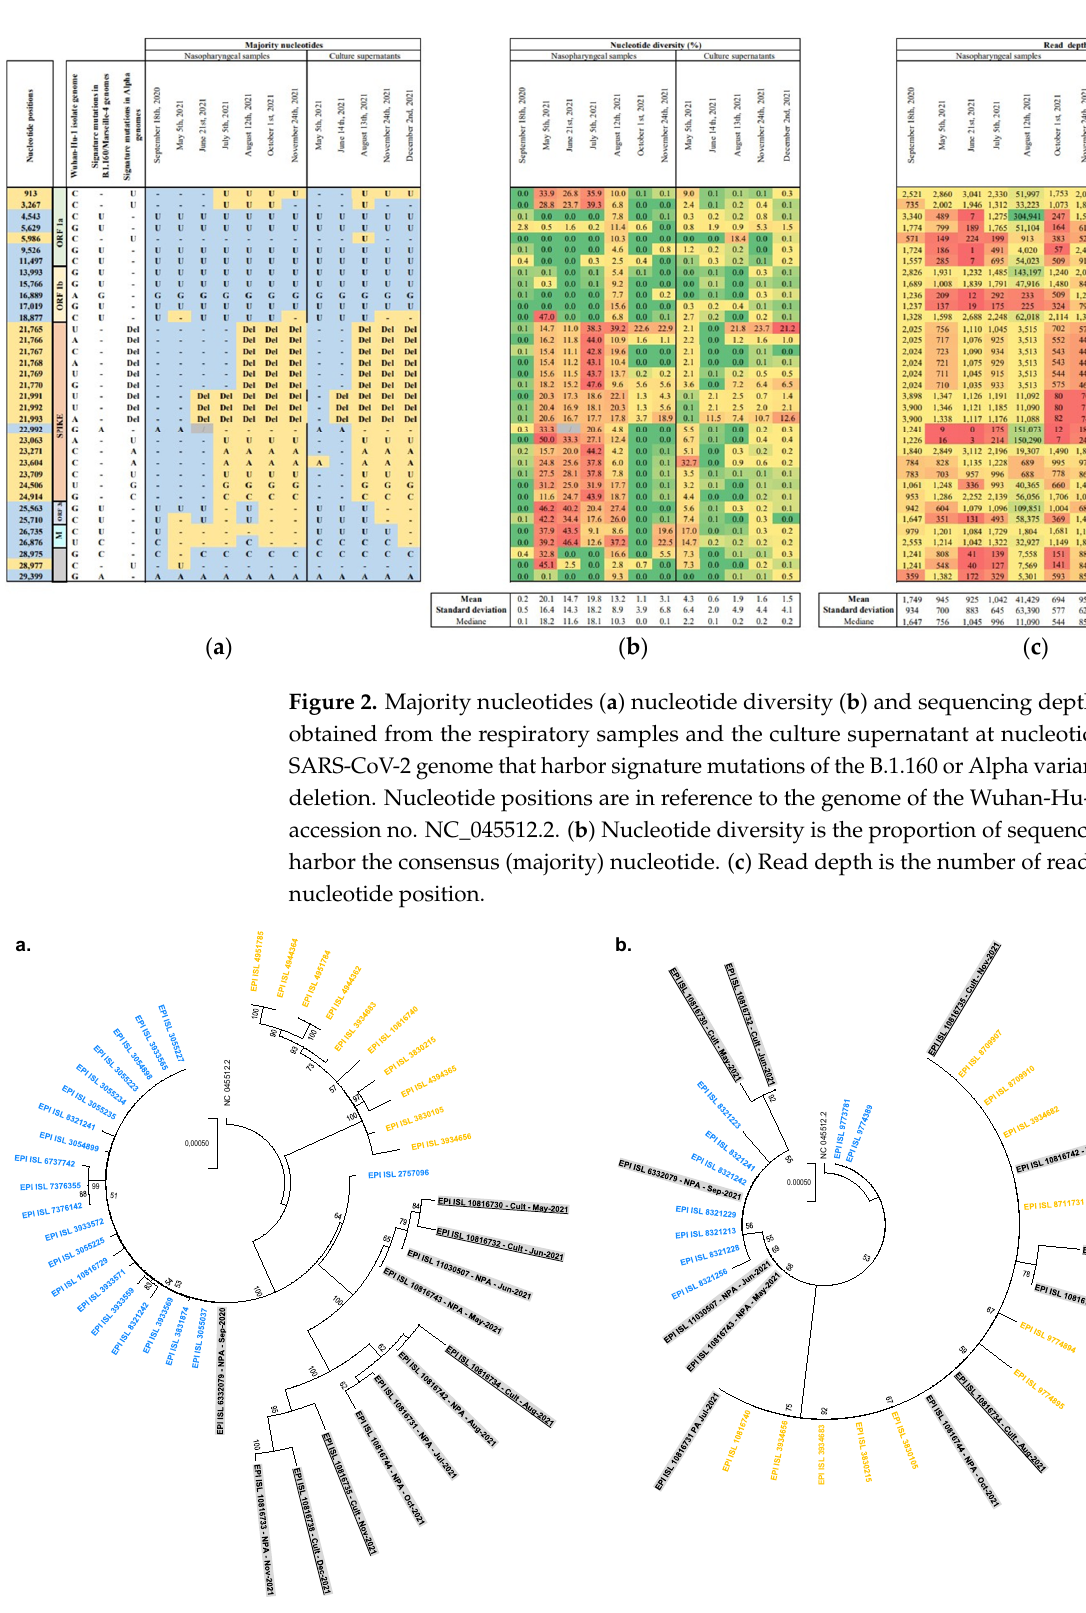
Figure 3. Phylogenetic analyses based on SARS-CoV-2 genomes ( a ) and spike gene sequences ( b ). Sequences obtained from the case-patient are indicated by a grey background, and those obtained from cultures are underlined. Other sequences from our SARS-CoV-2 sequence database are indi- cated by a blue font when classified as of the B.1.160 variant, and by a yellow font when classified as of the Alpha variant. Sequences are labeled with their GISAID (https://www.gisaid.org/; accessed on 18 May 2022) [34] identifiers. Trees are rooted with the genome of the Wuhan-Hu-1 isolate Gen- Bank accession no. NC_045512.2.2.3. Genome of the initial virus.